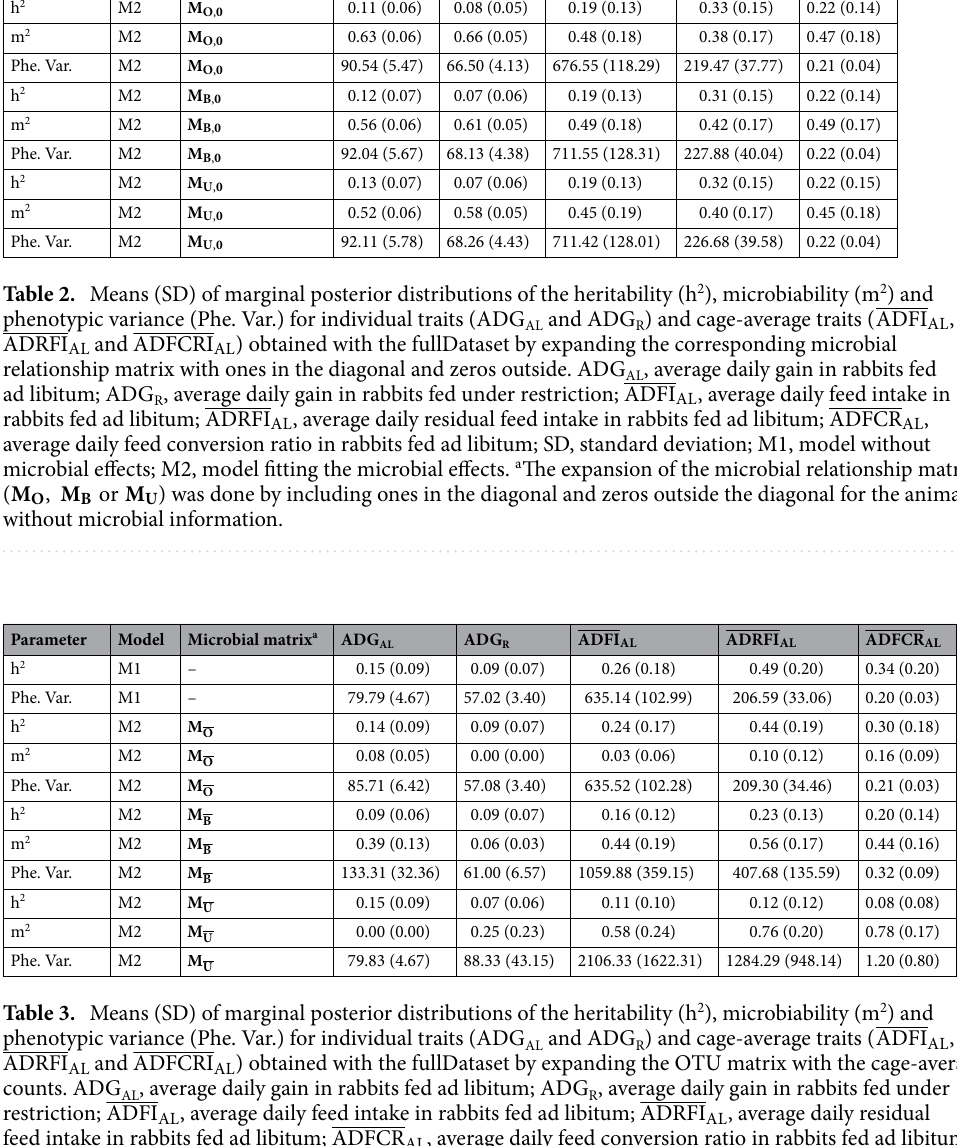
Table 3. Means (SD) of marginal posterior distributions of the heritability (h 2 ), microbiability (m 2 ) and phenotypic variance (Phe. Var.) for individual traits (ADG AL and ADG R ) and cage-average traits ( ADFI AL , ADRFI AL and ADFCRI AL ) obtained with the fullDataset by expanding the OTU matrix with the cage-average counts. ADG AL , average daily gain in rabbits fed ad libitum; ADG R , average daily gain in rabbits fed under restriction; ADFI AL , average daily feed intake in rabbits fed ad libitum; ADRFI AL , average daily residual feed intake in rabbits fed ad libitum; ADFCR AL , average daily feed conversion ratio in rabbits fed ad libitum; SD, standard deviation; M1, model without microbial effects; M2, model fitting the microbial effects. a The expansion of the microbial relationship matrix ( M O , M B or M U ) was done before computing the respective distance matrices, assigning to the animals without microbial information the cage-average of the CSS normalized OTU counts.